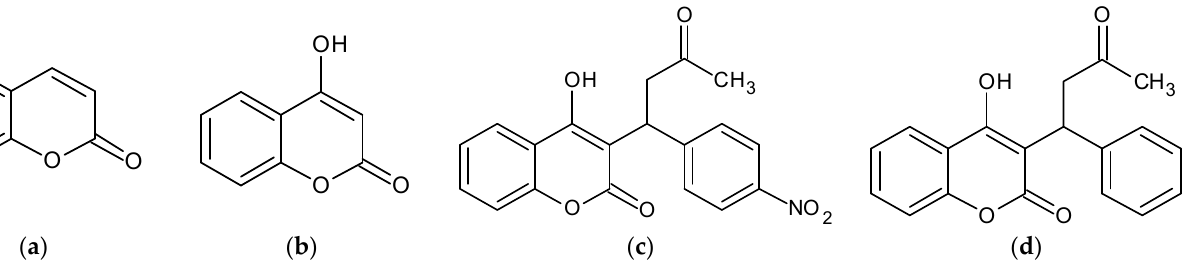
Figure 1. Structure of coumarin derivatives. ( a ) Coumarin, ( b ) 4 − hydroxycoumarin, ( c ) acenocoumarol, and ( d ) warfarin.